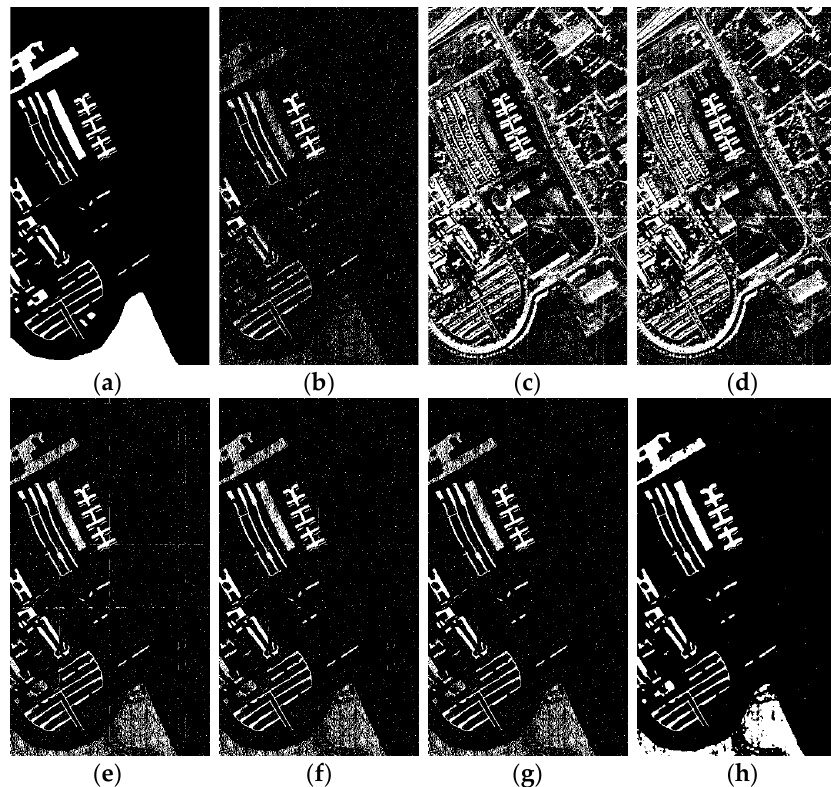
Figure 7. Label maps, including: ( a ) ground truth map; and change detection results yielded by: ( b ) K-Means (OA = 90.44%); ( c ) SAM + K-Means (OA = 68.15%); ( d ) ASCD + K-Means (OA = 69.31%); ( e ) PCA + K-Means (OA = 93.77%); ( f ) LRSD + K-Means (OA = 93.84%); ( g ) LRSD_TV + K-Means (OA = 93.93%); and ( h ) LRSD_SS + K-Means (OA = 97.00%), tested on one randomly selected set of bitemporal HSI of Data 10. The changed are labeled by “1” and colored in white, while the unchanged are labeled by “0” and colored in black. OA is short for overall accuracy. Table 2. Evaluation of change detection results for the real-world bitemporal